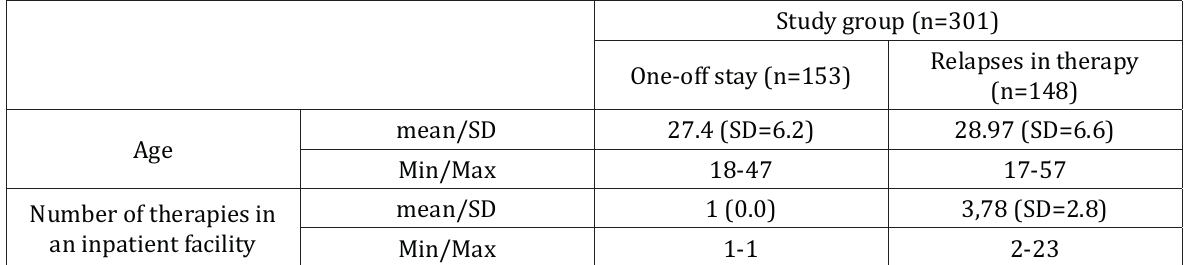
Table 1. Statistical characteristics of age in the study and control groups and the amount of therapy in an in-patient center in the study